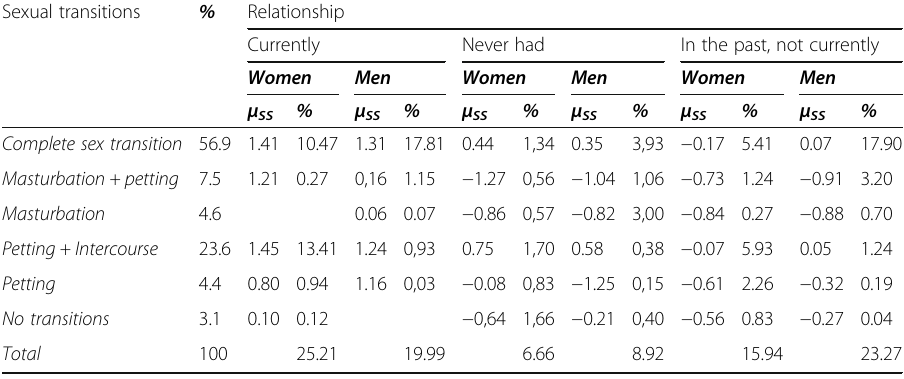
Table 2 Average sexual satisfaction ( μ sexual transitions Sexual transitions